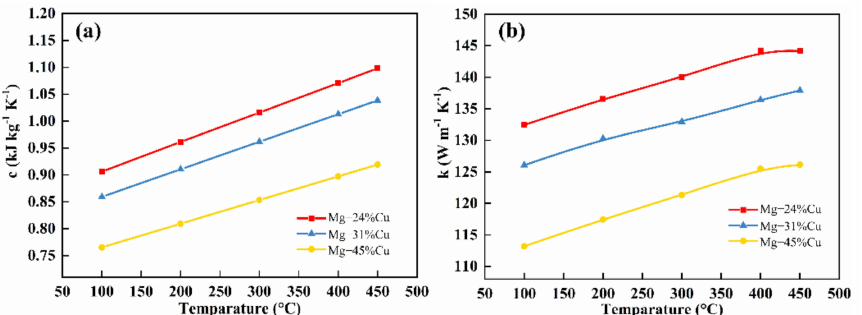
Figure 6. Specific heat capacity and thermal conductivity of Mg–Cu eutectic alloys: ( a ) specific heat capacity and ( b ) thermal